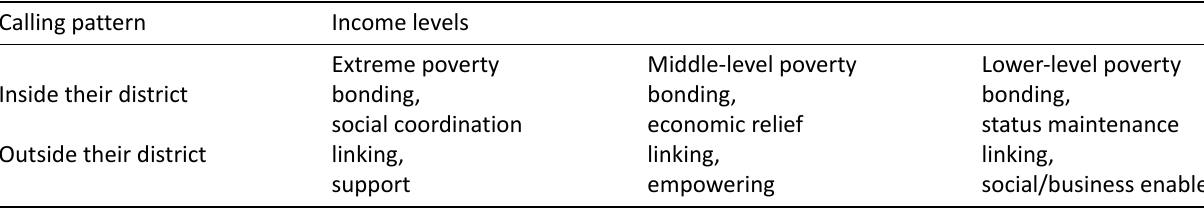
Table 5. Functional roles of mobile phones by poverty category. Calling